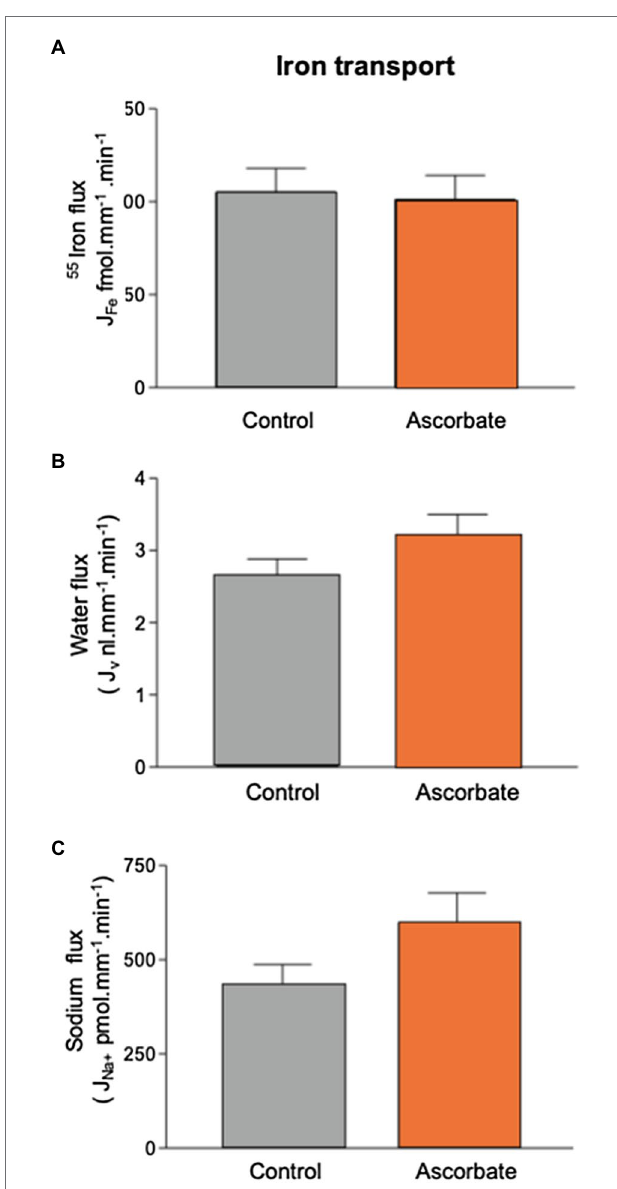
FIGURE 3 | Effect of 1 mmol.l − 1 ascorbate on 55 Fe, water, and Na + flux in microperfused renal PCT. Surface S2 PCTs were microperfused in vivo, and the effect of 1 mmol.l − 1 ascorbic acid on 55 Fe flux determined. Control perfusate contained 12 μ mol.l − 1 55 FeCl 3 . Ascorbate perfusate consisted of control perfusate plus 1 mmol.l − 1 ascorbic acid (A) Mean Fe flux of 105.2 ± 12.7 fmol.mm − 1 .min − 1 ( n = 19) was measured. Addition of 1 mmol.l − 1 ascorbic acid resulted in a mean Fe flux of 101.2 ± 13.0 fmol.mm − 1 .min − 1 ( n = 15). (B) Water flux by microperfused PCT was not significantly affected by the addition of ascorbic acid (2.7 ± 0.2; n = 19 to 3.2 ± 0.3 nl.mm − 1 .min − 1 ; n = 15). (C) Sodium flux was slightly elevated by inclusion of ascorbate, but the difference did not reach statistical significance at 0.5% level (434.9 ± 52.2; n = 19 to 598 ± 79 pmol.mm − 1 .min − 1 ; n =